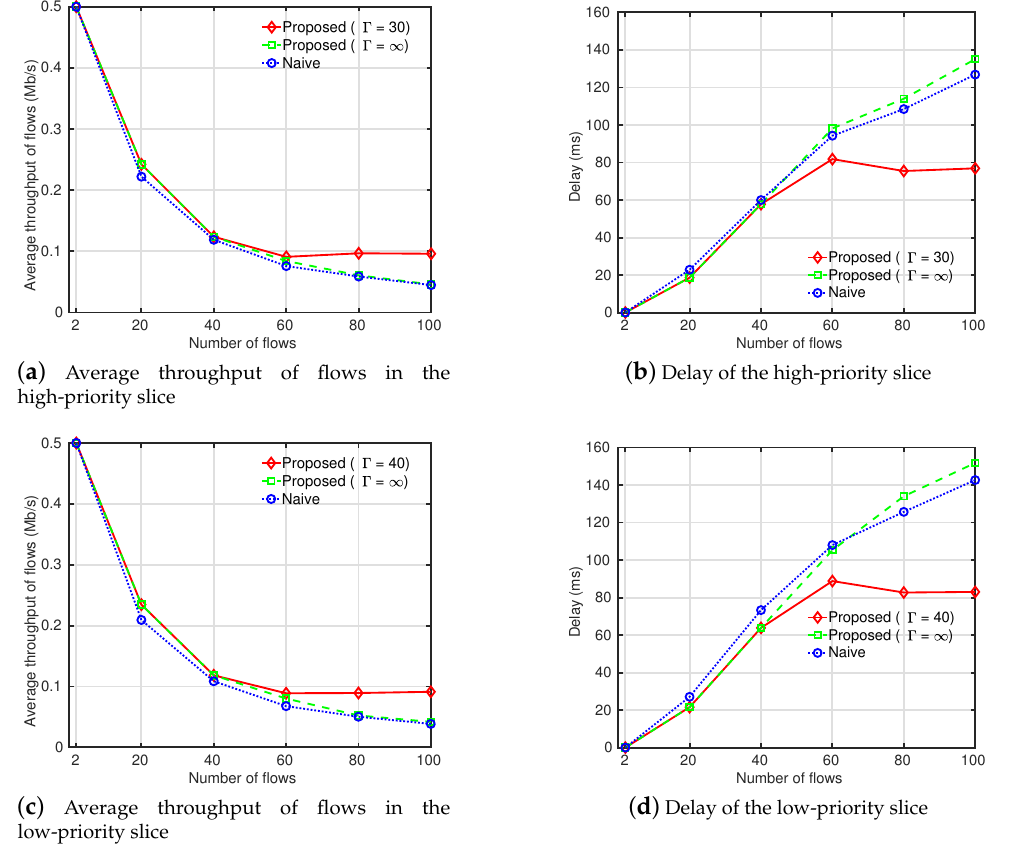
Figure 5. Throughput and delay with respect to different numbers of flows.